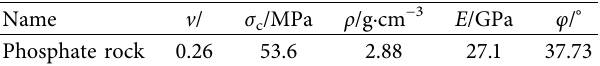
Figure 12: Classification curve of cracking mode of closed crack tip under compressive stress. Table 1: Basic physical and mechanical parameters of phosphate rock.